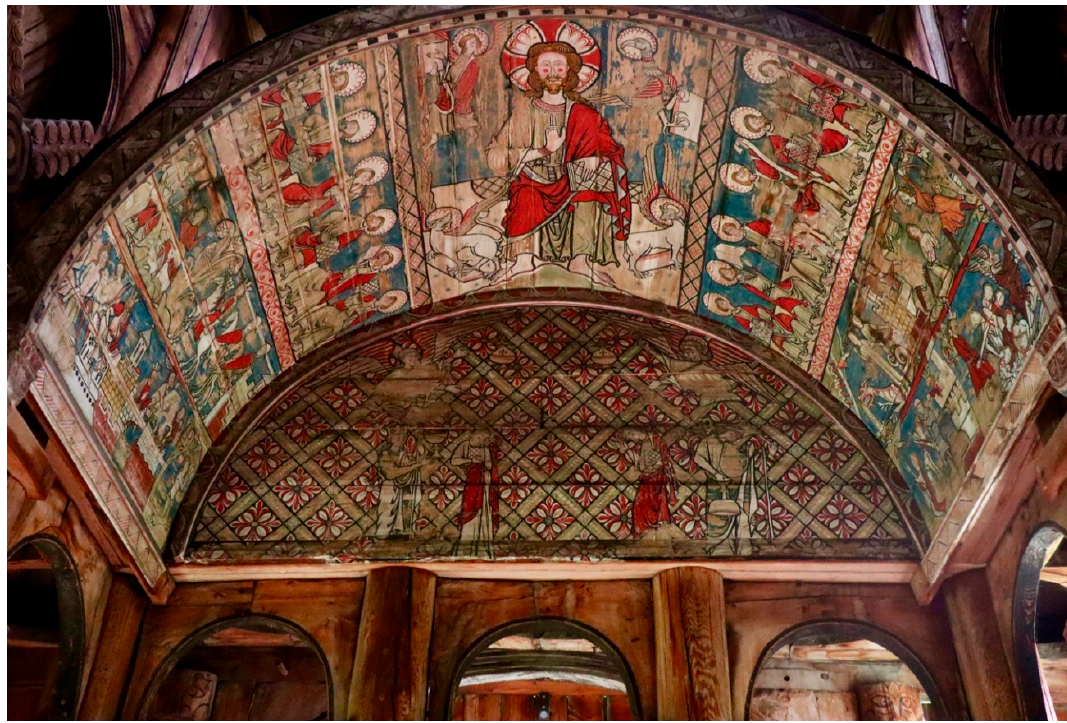
Figure 9. The Torpo canopy. Paintings from the thirteenth century. Photo: Kaja M. H. Hagen.